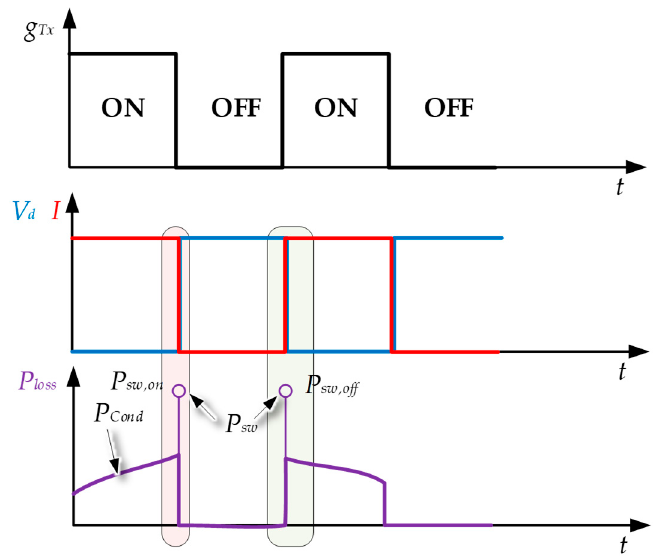
Figure 6. Electric behavior modeling, ideal conduction and switching waveforms and conduction and switching losses estimation [19].